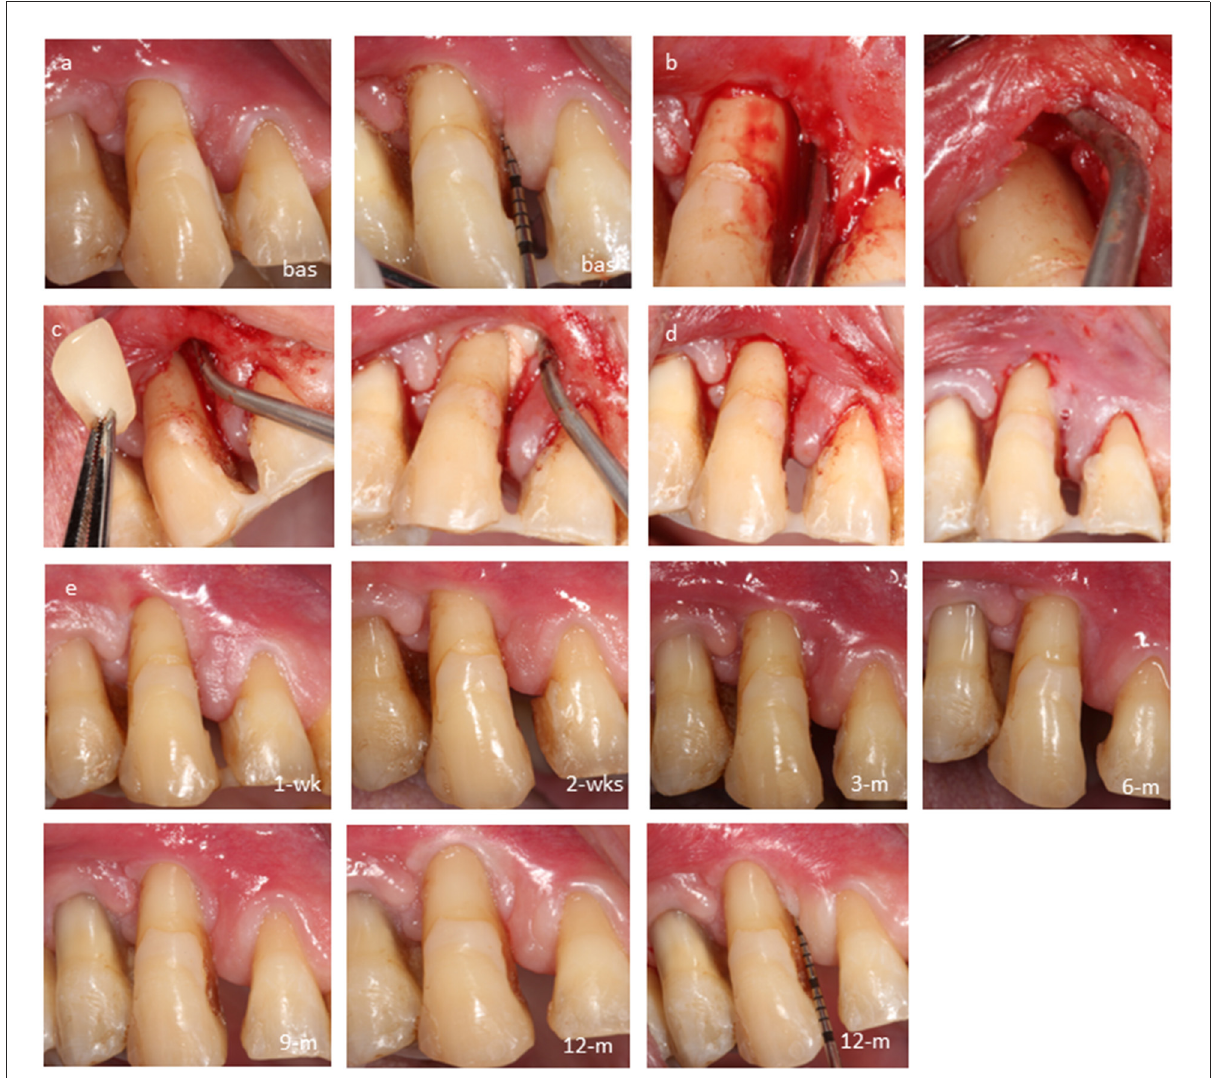
FIGURE3 Case-2, #13 mesial: (a) baseline probing before anesthesia, (b) closed retraction of gingival flaps including the papilla to obtain access to the bottom of defect, (c) subgingival application of the biocomplex; (d) immediate post-operative view; crosslinked autologous fibrin platelet lysate by CaCl 2 seals the sulcus; (e) follow-ups at 1-, 2- weeks, 3-, 6-, 9- and